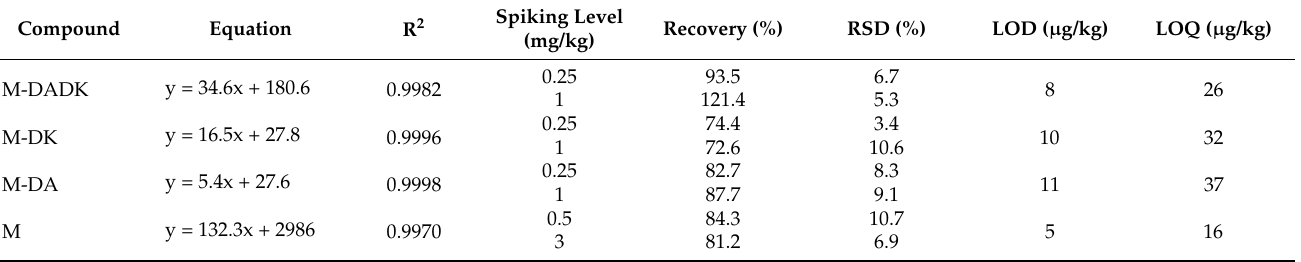
Table 2. Calibration equations, R 2 values, recoveries and relative standard deviation (RSD, n = 3), quantification limits (LOQs), and detection limits (LODs) of metribuzin and its metabolites in soil.